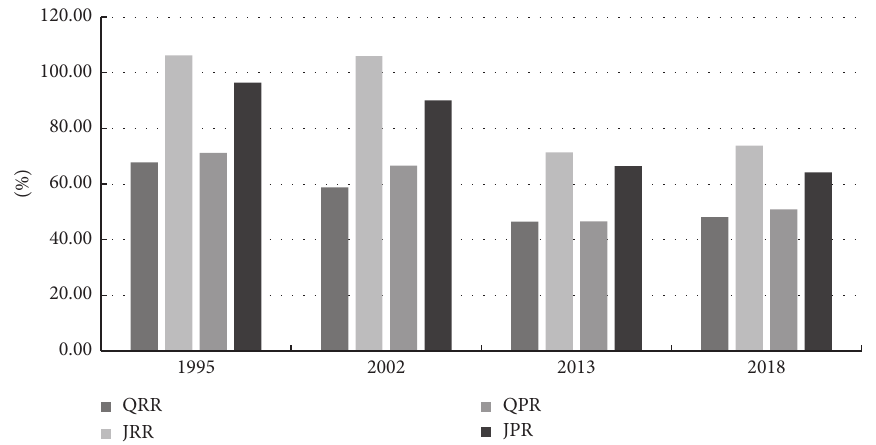
Figure 5: Pension security level of employees in enterprises, organs, and institutions.